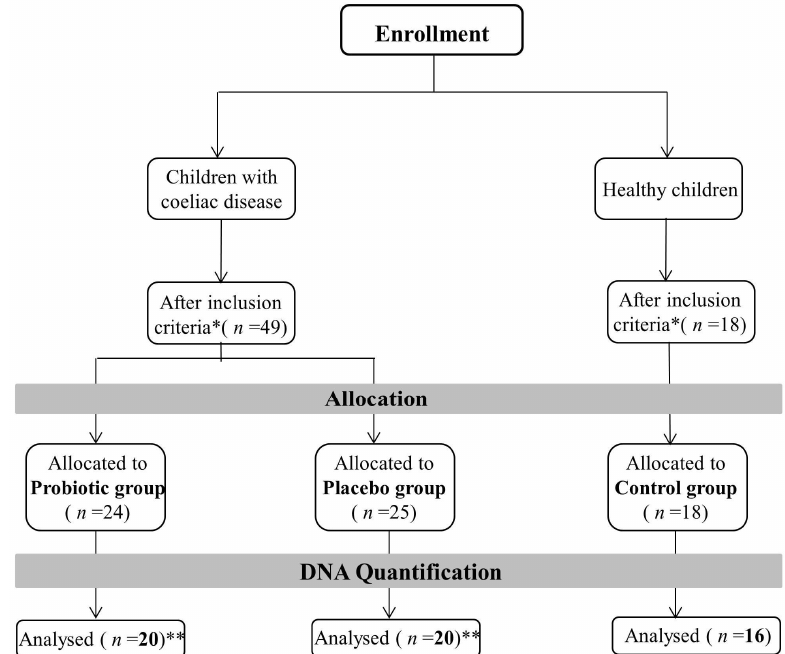
Figure 1. Summary of inclusion/exclusion criteria adopted for samples selection. Samples who